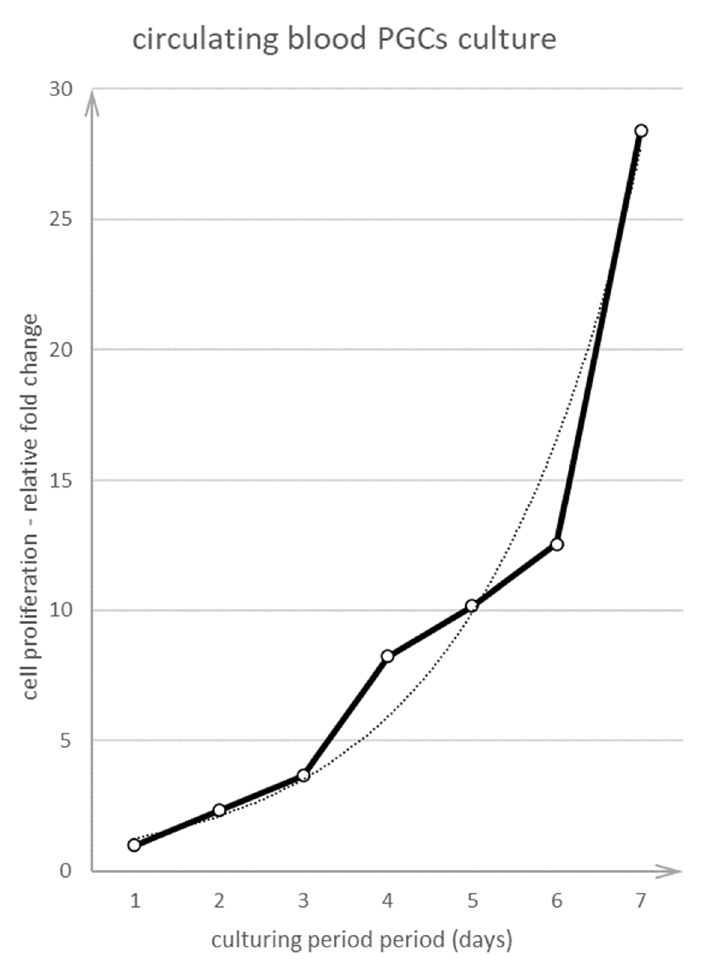
Figure 7. Proliferation curve of cPGCs cultivated on a chicken embryo feeder layer at pH 8.0. The live cPGCs were counted directly in the culture by using the darkfield illumination method.